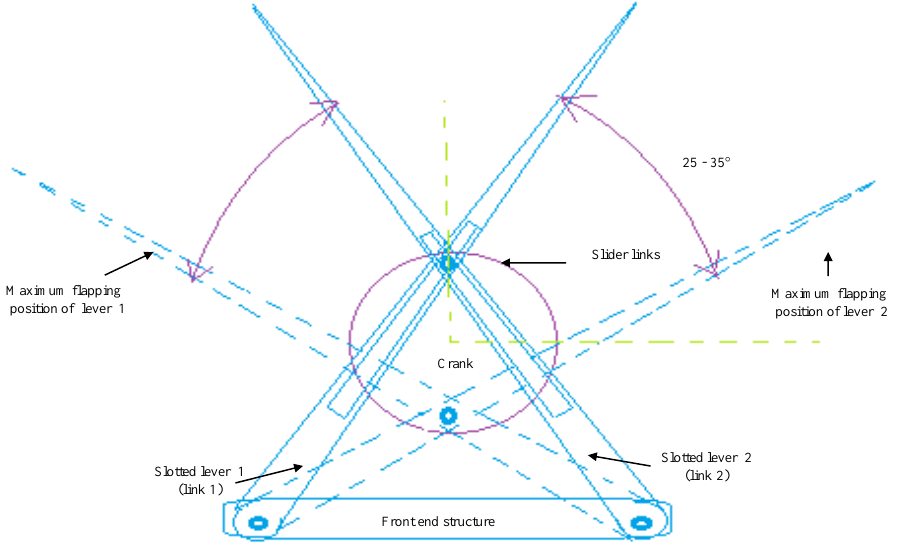
Figure 1. SC–SDL design